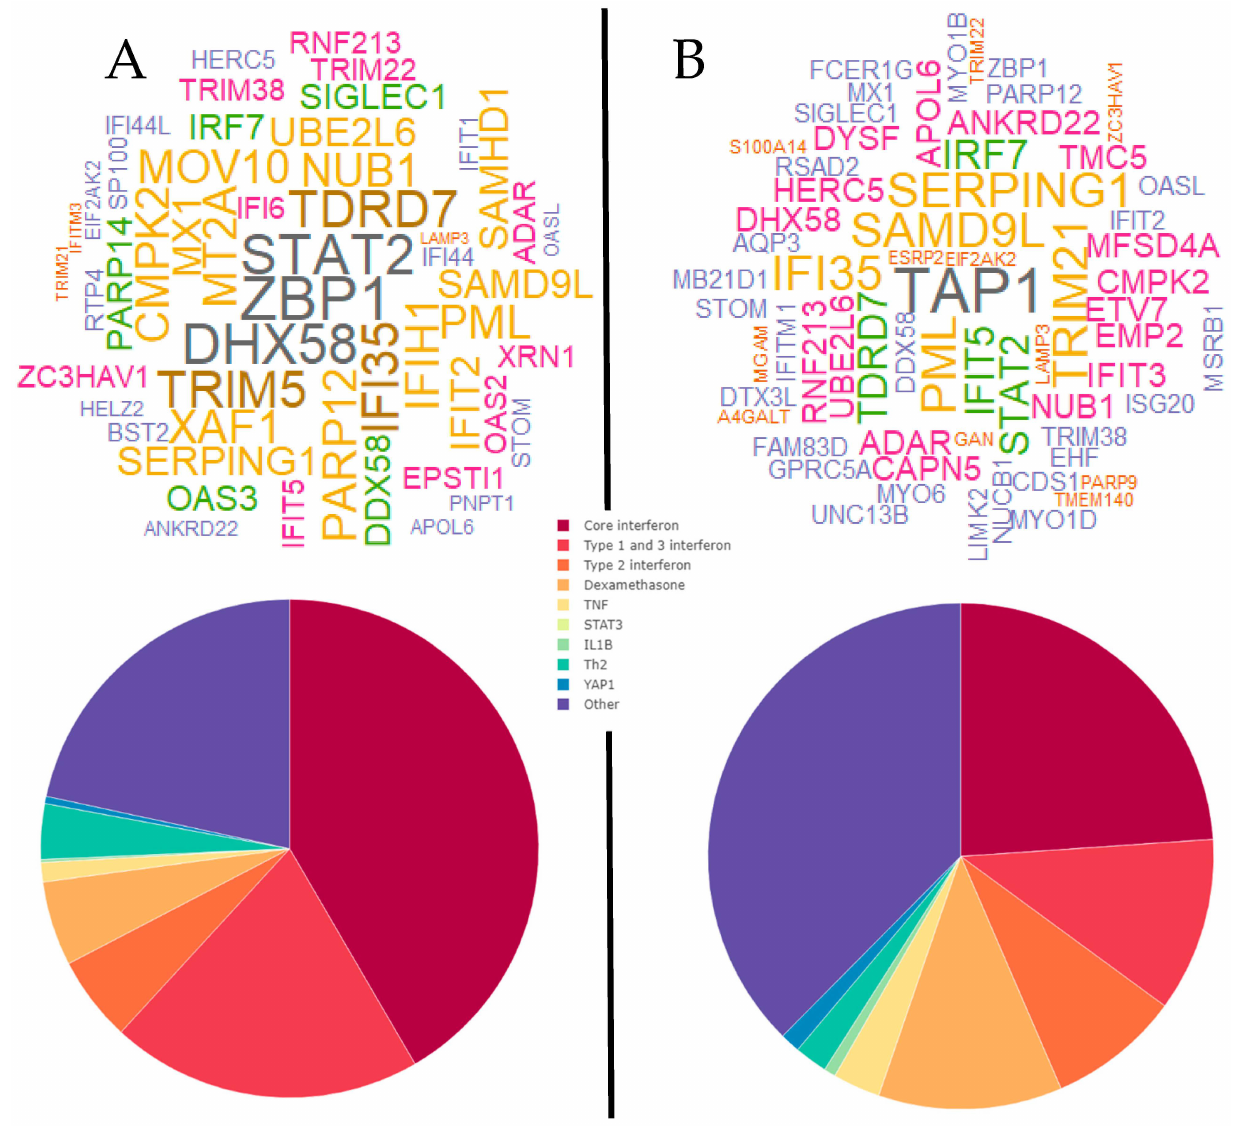
Figure 10. Word cloud plots of the top 20 hub genes for each individual at the acute (Day 1–3) visit ( top ) and averaged network pathway proportions ( bottom ) for clusters A and B. Word color and size indicates